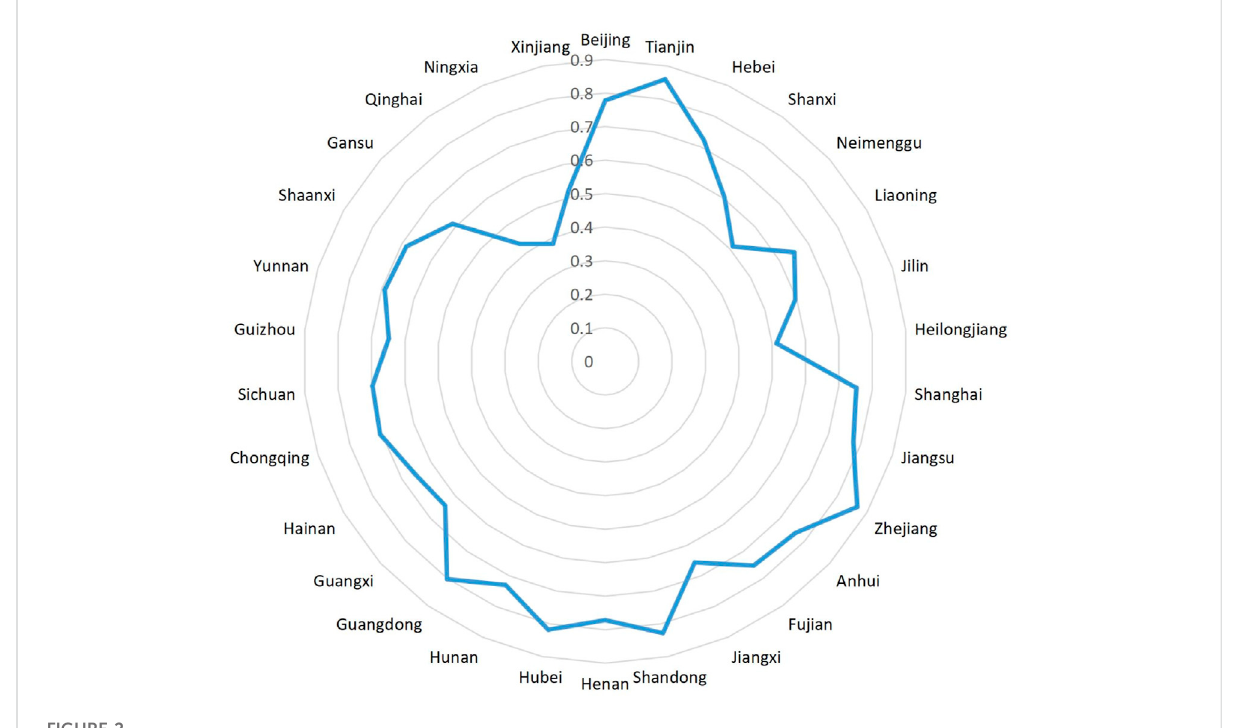
FIGURE 2 Comprehensive evaluation value of provincial circular economy